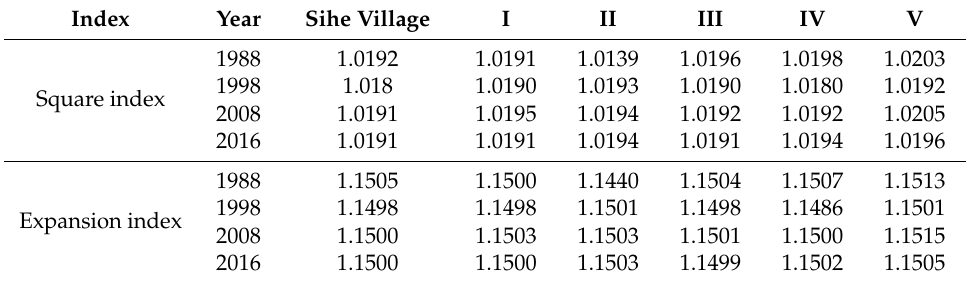
Table 11. The changes in the morphology of rural settlement plaques in Sihe village in